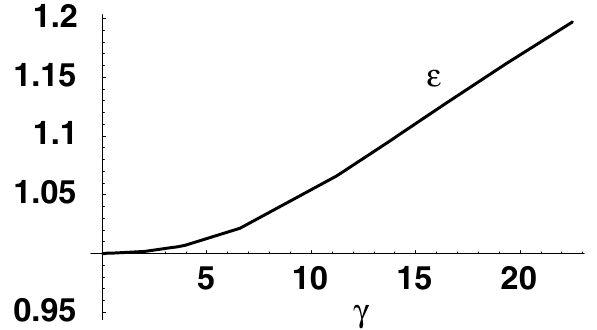
FIG. 8. The transverse dimensionless emittance " vs the space-charge strength (cid:7) . The true dimensional emittance, calculated as a position-momentum uncertainty product, is just E (cid:4) "(cid:10)